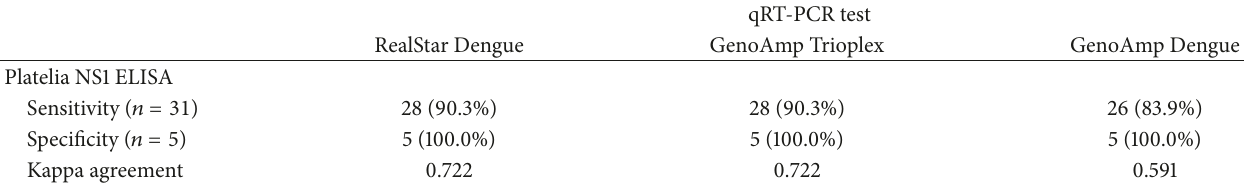
Table 2: Sensitivity, specificity, and kappa agreement of qRT-PCR tests for detection of DENV in patient sera.